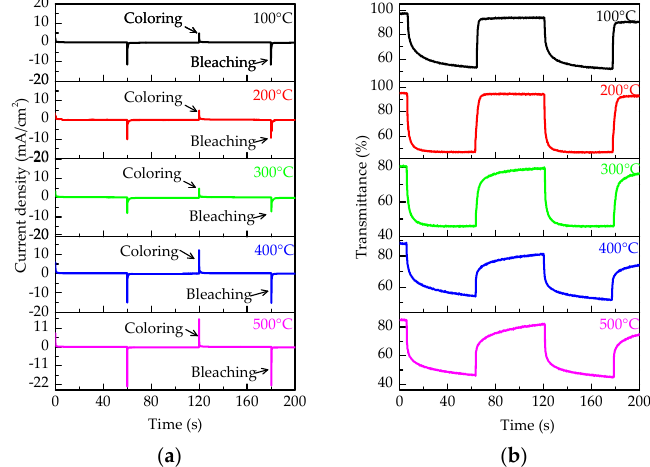
Figure 4. ( a ) Current change of WO 3 films at different annealing temperature. The applied voltage was ±2.5 V and the WO 3 films were placed in the cathode; ( b ) change of transmittance (at 600 nm) of WO 3 films at different annealing temperature.